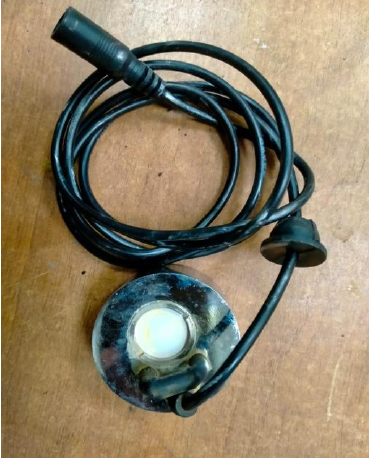
Figure 4. Ultrasonic humidifier.